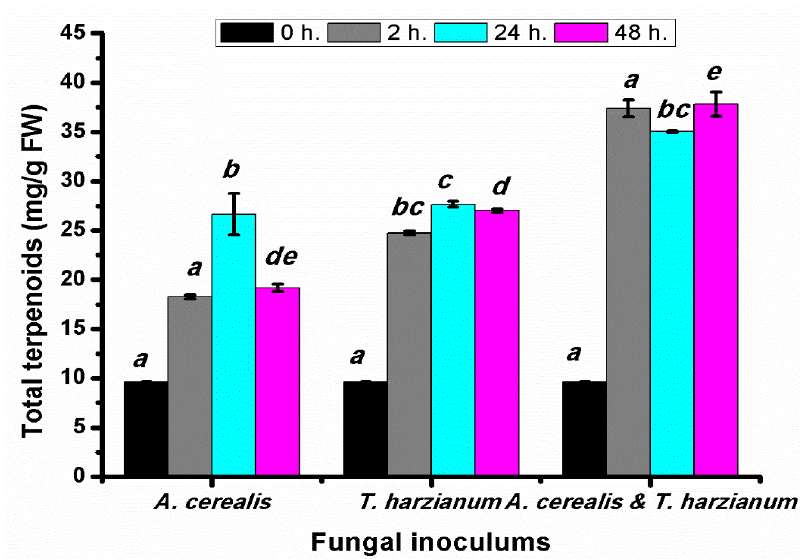
Figure 8. Total terpenoids (mg/g FW) of tomato leaves ( S. lycopersicum L.) under the effect of pathogen ( Alternaria cerealis MT808477), and pathogen inhibitor ( Trichoderma harizainum ) after 0, 2, 24, 48 h of inoculation, data are means ± SD ( n = 3), with statistically significant differences ( p < 0.05).